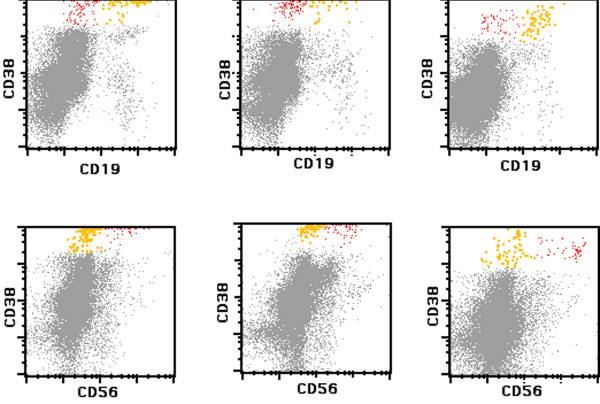
Comparison of CD19 and CD56 expression in plasma cells of monoclonal gammopathy of undetermined significance (MGUS). The top row shows CD19 expression in polytypic (yellow) and neoplastic (red) plasma cells in three different MGUS cases. The corresponding CD56 expression is demonstrated in the bottom row.